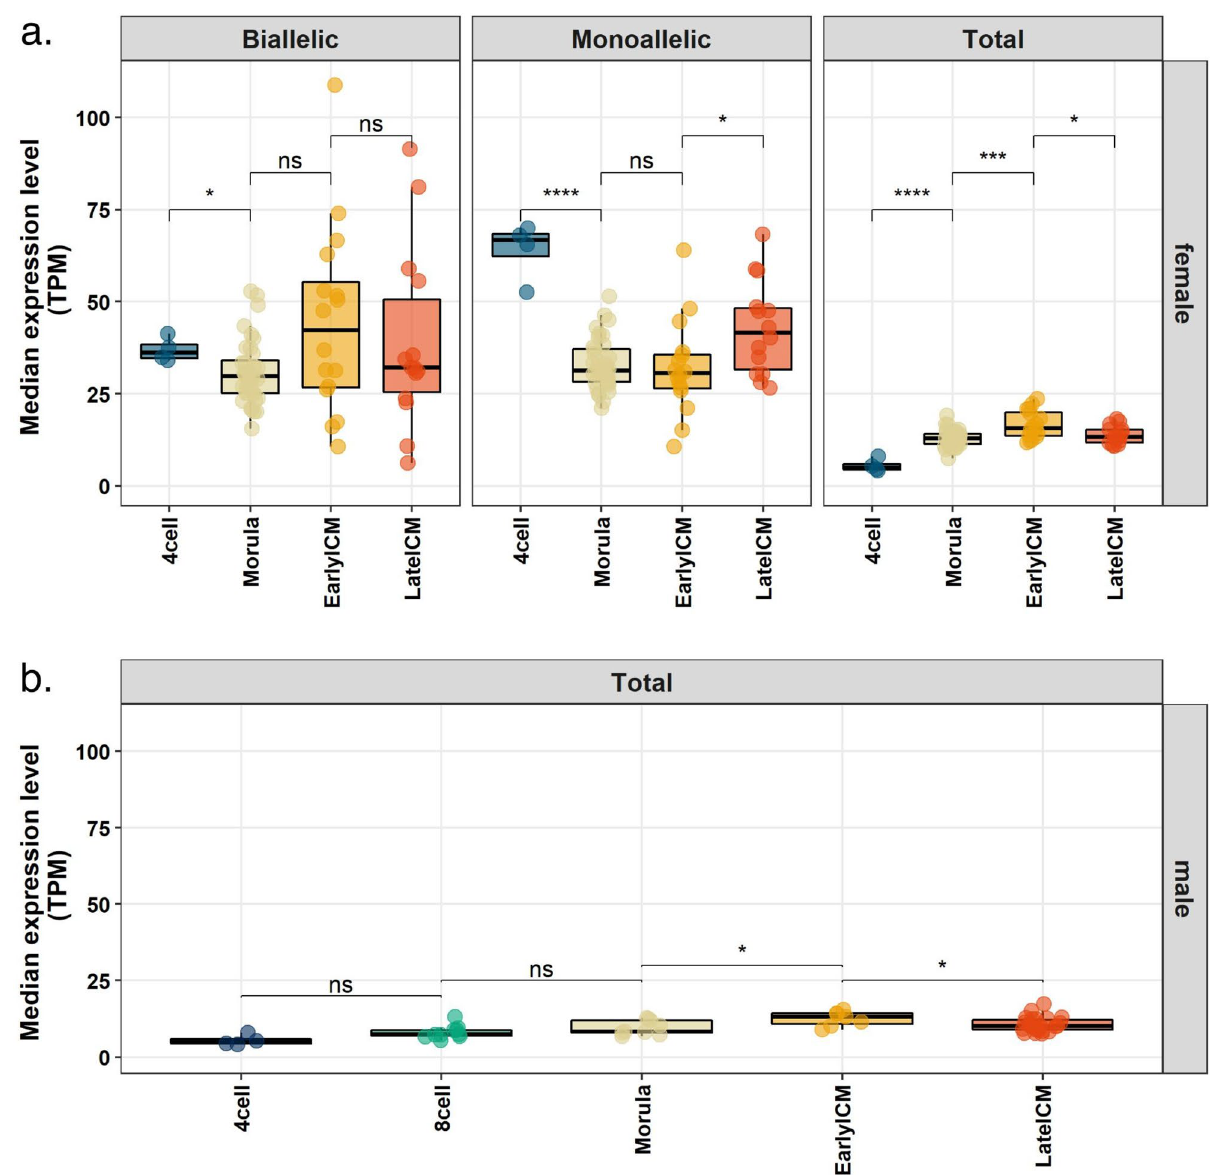
Figure 3. Expression levels of X-linked genes in marmoset preimplantation embryos. Each dot represents a single cell. Distribution of the median expression levels of X-linked genes as follows: ( a ) left panel: biallelically expressed; middle panel: monoallelically expressed; right panel: all X-linked expressed genes in each cell of female embryos (biallelic, monoallelic and non-informative). ( b ) Median expression levels of all expressed X-linked genes in each cell of male embryos. Stages were compared to each other using an unpaired Wilcoxon test. (*) P-value ≤ 0.05; (***) P-value ≤ 0.001; (****) P-value ≤ 0.0001; (ns) not significant (P-value ≥